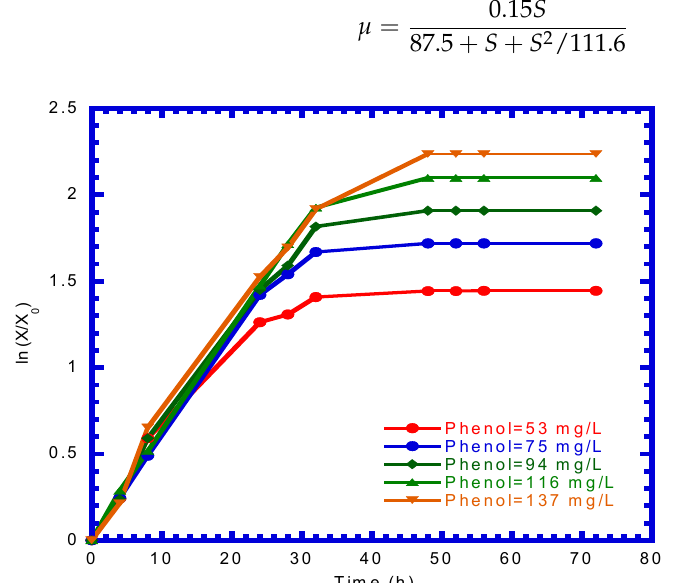
Figure 3. Cell growth rate to estimate the specific growth rate at different initial phenol concentrations.